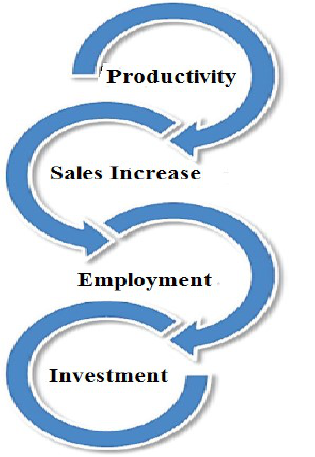
Fig. 2. The expected benefit chain for Industry